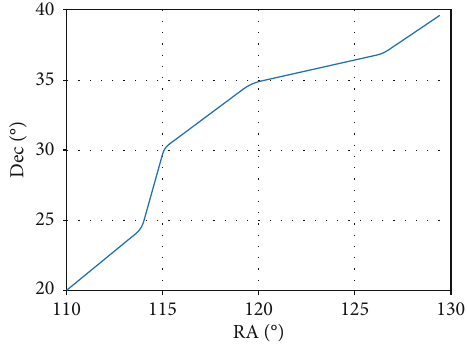
Figure 16: Main LoS vector.